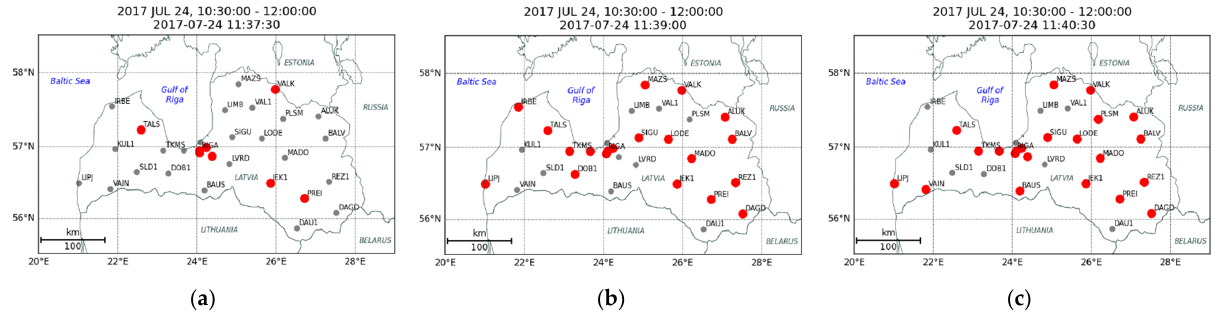
Figure 4. A schematic map of movement of “evil wave” over the territory of Latvia: ( a – c ). When sorting the disturbances, the occurrence of faulty solutions was found in nu- merous stations simultaneously. The movement of these disturbances over the territory of Latvia can be described as a “waveform”. This could be interpreted as ionospheric scin- tillations, exposed in a form of table (Table 3, Supplementary Materials Tables S4 and S7) and/or graphs (Figures 4 and 5). Table 3. Sample list of stations (DOMES), date and time of simultaneous scintillations.